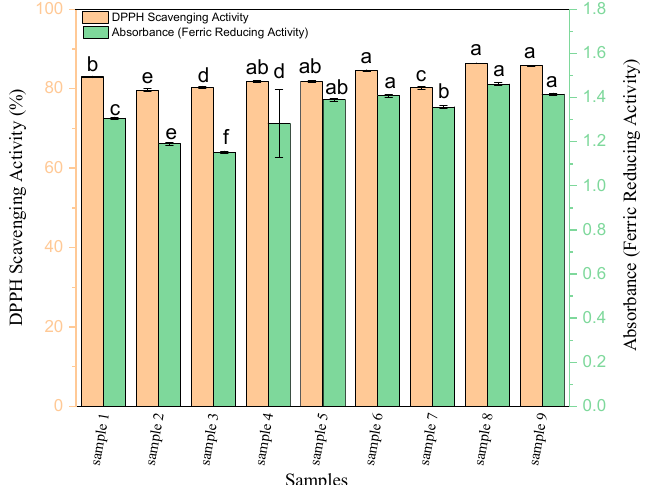
Figure1. DPPHscavengingactivity(%)andferric-reducingpoweractivityoftomatoproteinhydrolysate Figure 1. DPPH scavenging activity (%) and ferric-reducing power activity of tomato protein (OSPH) under di ff erent conditions. Data are mean ± SD of three replications and the values for each hydrolysate (OSPH) under different conditions. Data are mean ± SD of three replications and the activity with di ff erent letter are significantly di ff erent ( p < values for each activity with different letter are significantly different ( p < 0.05).